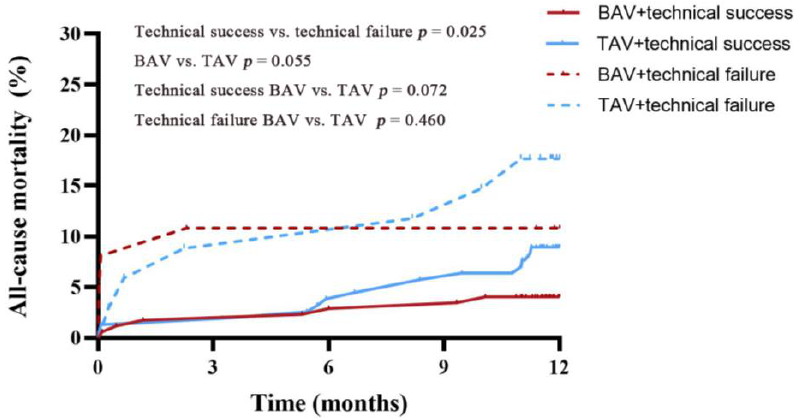
Figure 1. Kaplan–Meier curves demonstrating all-cause mortality at 1 year in BAV and TAV groups, stratified by technical success or technical failure. p -values were calculated using log rank tests. BAV = bicuspid aortic valve; TAV = tricuspid aortic valve.